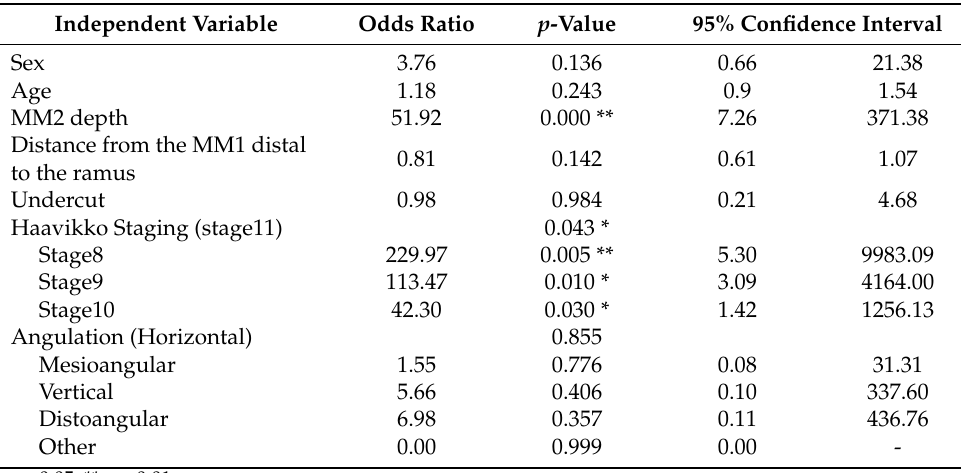
Figure 5. Panoramic radiographs with different angulations of MM2 between the three types. Table 4. Binary regression analysis of cyst in